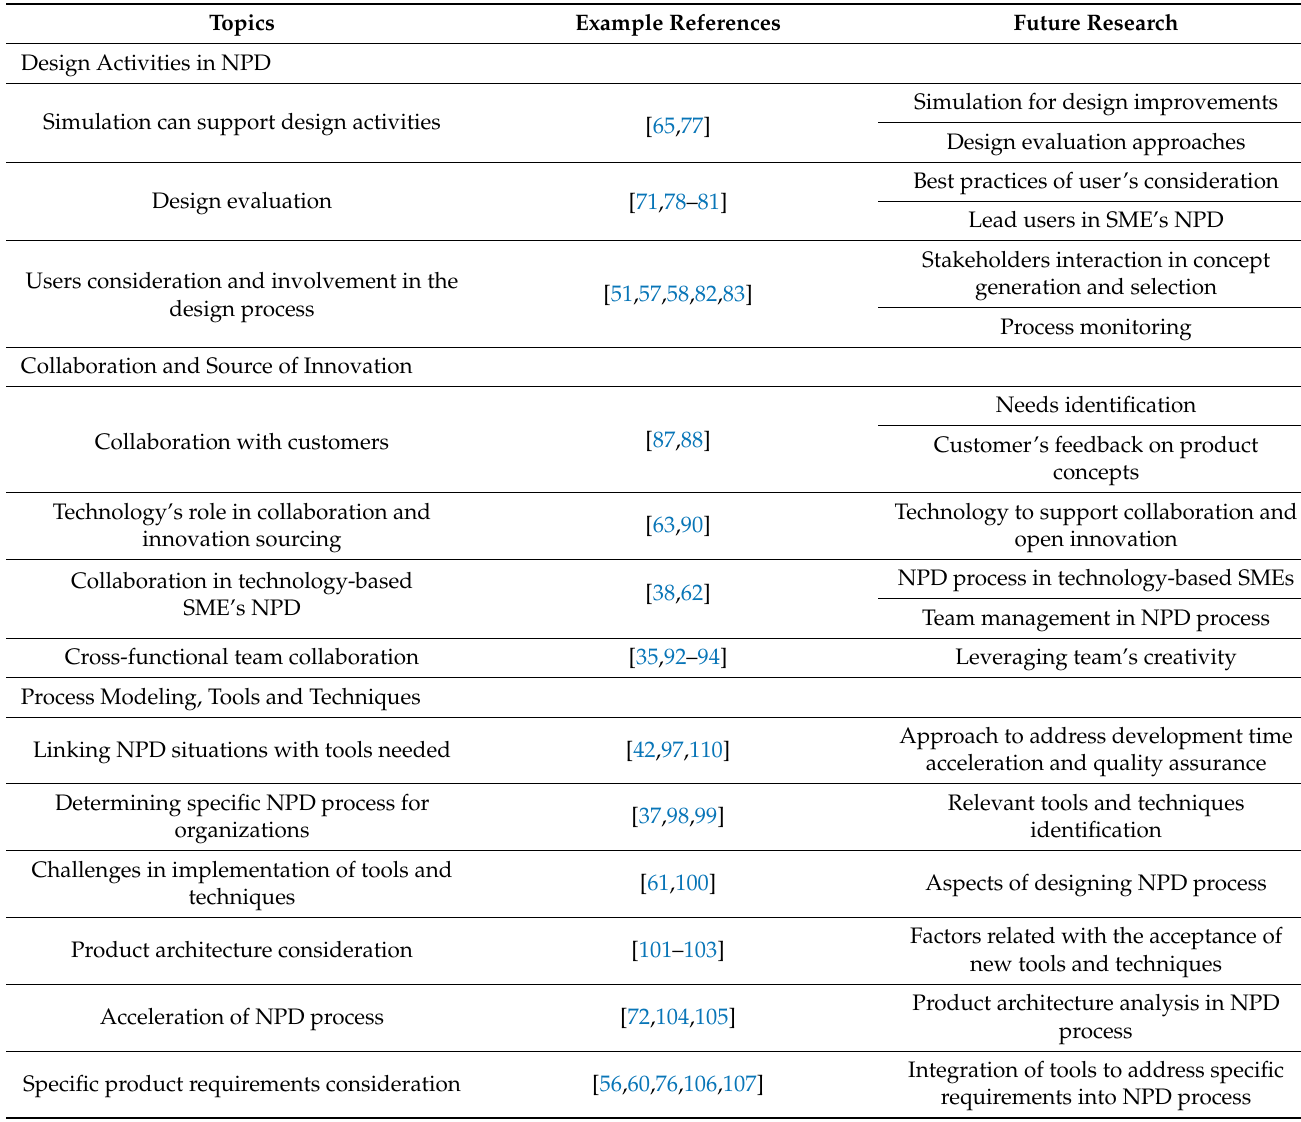
Table 7. Future research